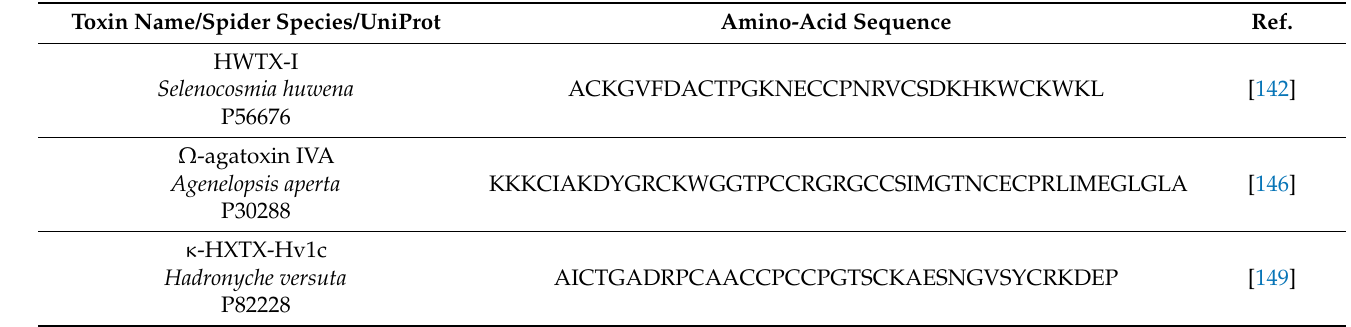
Table 3. The toxins of spider origin, with a suggested and demonstrated activity on nAChRs. Toxin Name/Spider Species/UniProt Amino-Acid Sequence